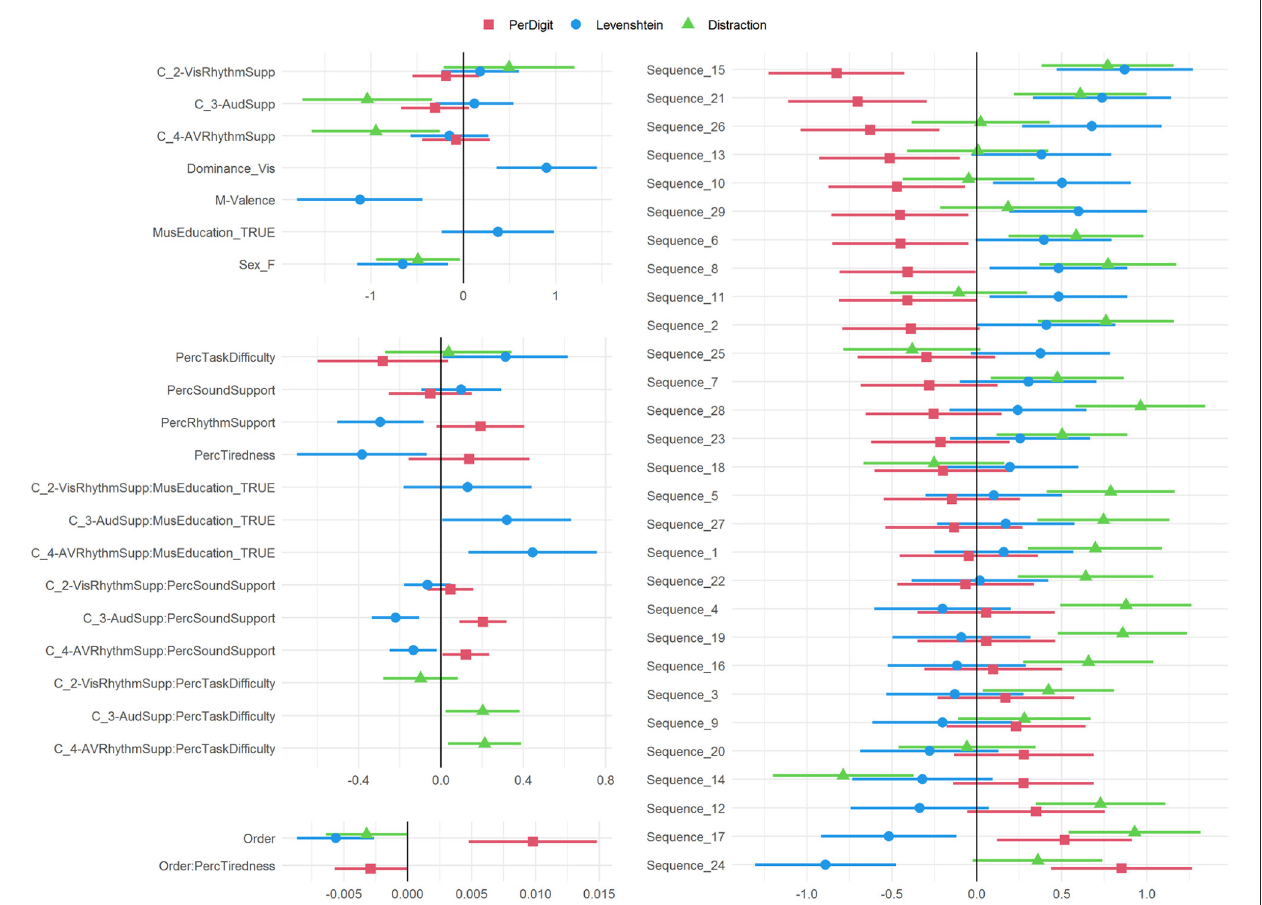
FIGURE 4 | Summary of all model variables with estimates and 95% confidence intervals. If the intervals do not overlap with the zero, the corresponding variable is significantly different from the not-listed reference value. In case of continuous variables this means that a one unit change is significant.